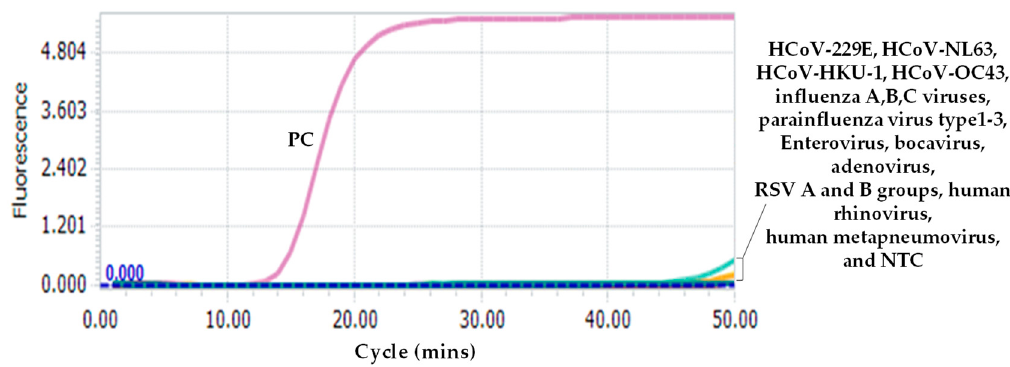
Figure 2. Specificity of the novel SARS-CoV-2 RT-LAMP assay. The common respiratory viruses used in this assay include: HCoV-HKU-1; HCoV-NL63; HCoV-OC43; HCoV-229E; influenza A, B, and C viruses; parainfluenza virus type 1–3; enterovirus; RSV A and B groups; human rhinovirus; human metapneumovirus; adenovirus; and Bocavirus. SARS-CoV-2 RNA standard was used as positive control (PC). NTC: non-template control.